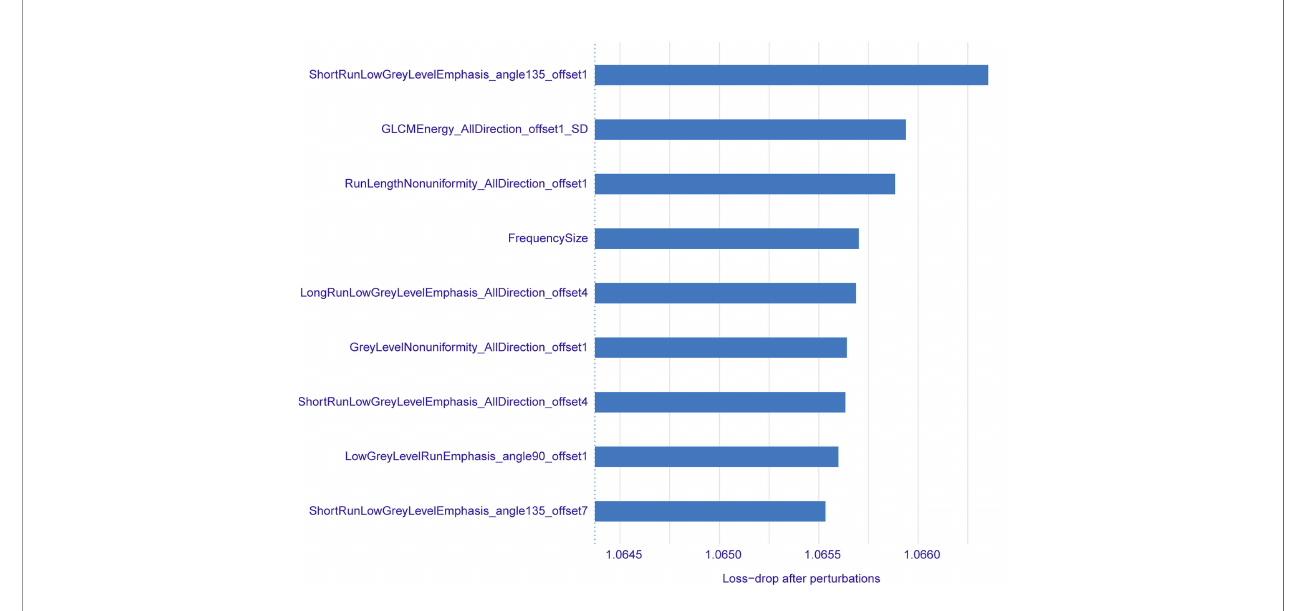
FIGURE 3 | Names, importance, and sorting of radiomics